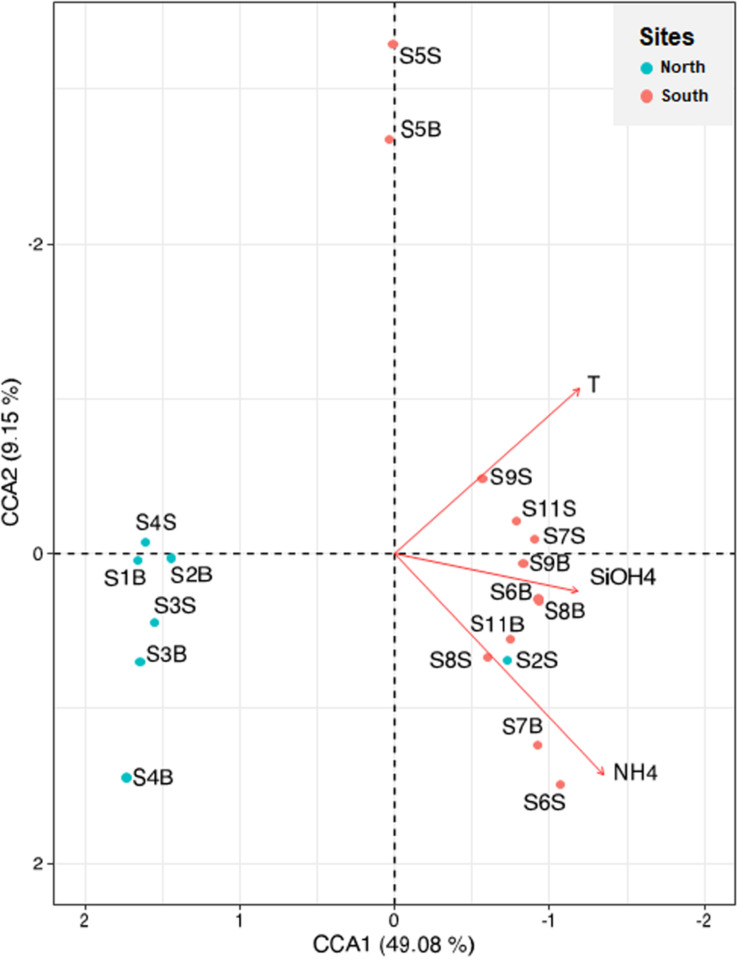
Canonical correspondence analysis visualizing the relationships between physicochemical environmental variables (arrows) and sampling sites (black circles) derived from ASV abundance data. Significant environmental variables are displayed (p < 0.05). S1 to S4 sample originated from North Tunisian coast; S5 to S11 samples originate from South Tunisian coast. B and S mean Bottom and Surface waters, respectively.